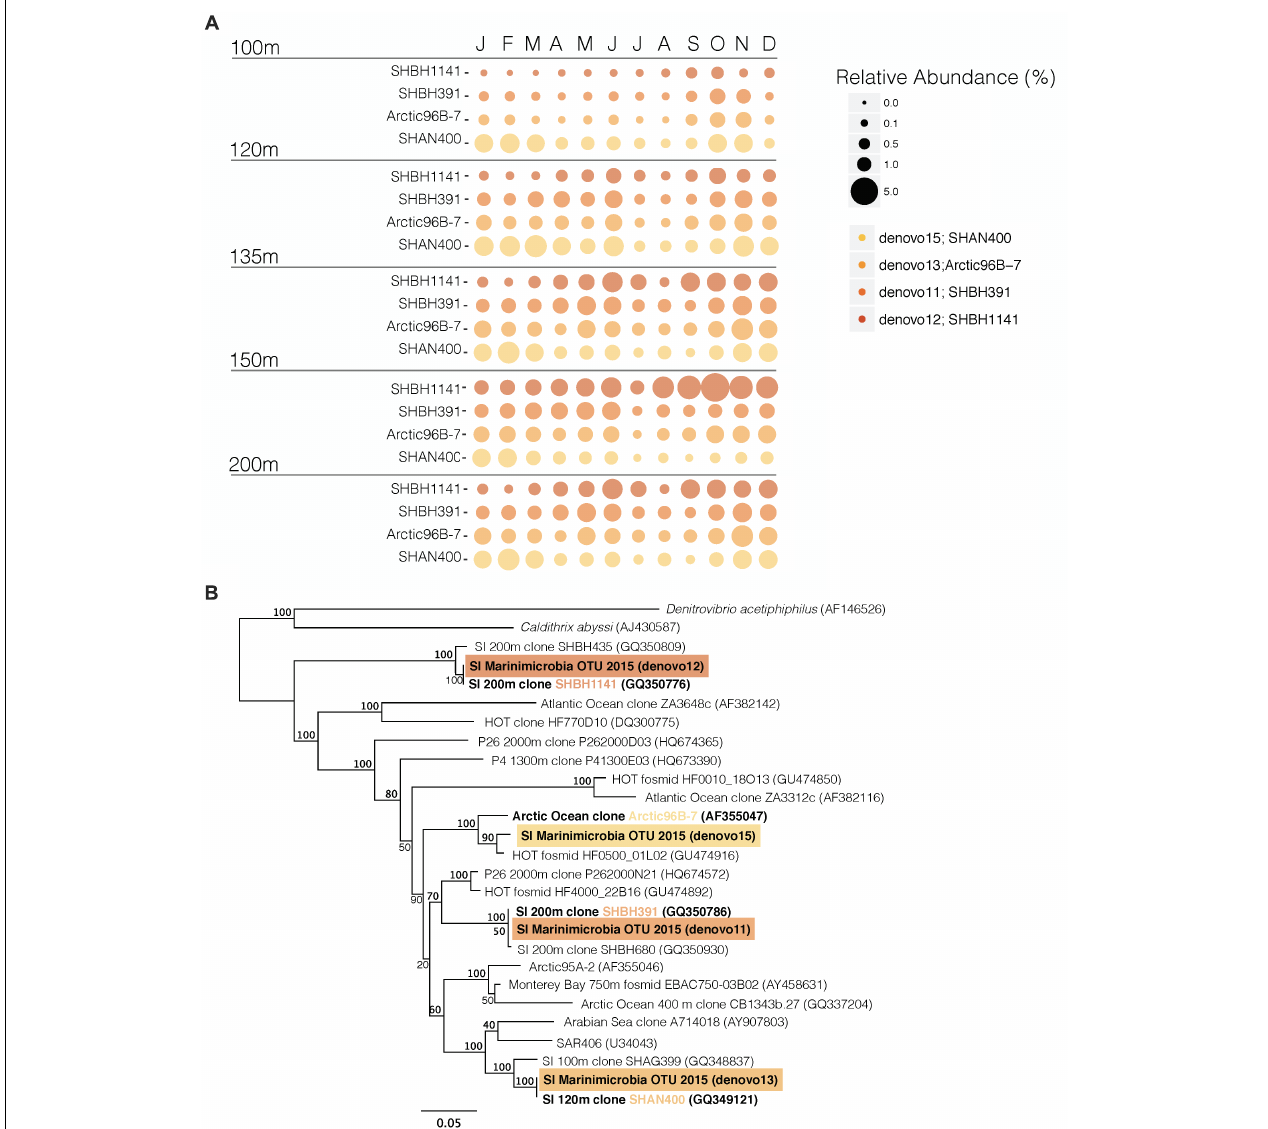
FIGURE 11 | OTUs from the Marinimicrobia phylum in SI. (A) Relative abundance of the 4 most abundant OTUs of the Marinimicrobia phylum in SI plotted by depths and months (B) maximum-likelihood phylogenetic tree of the small subunit rRNA for sequences of the Marinimicrobia clade (ML implemented with RaxML, 100 bootstraps). OTUs identified in this study are highlighted in a colored box. Previously identified SAGs or genome bins are in bold. The bar represents 5% estimated sequence divergence. Bootstrap value at the branch node indicate the robustness of the branching of the